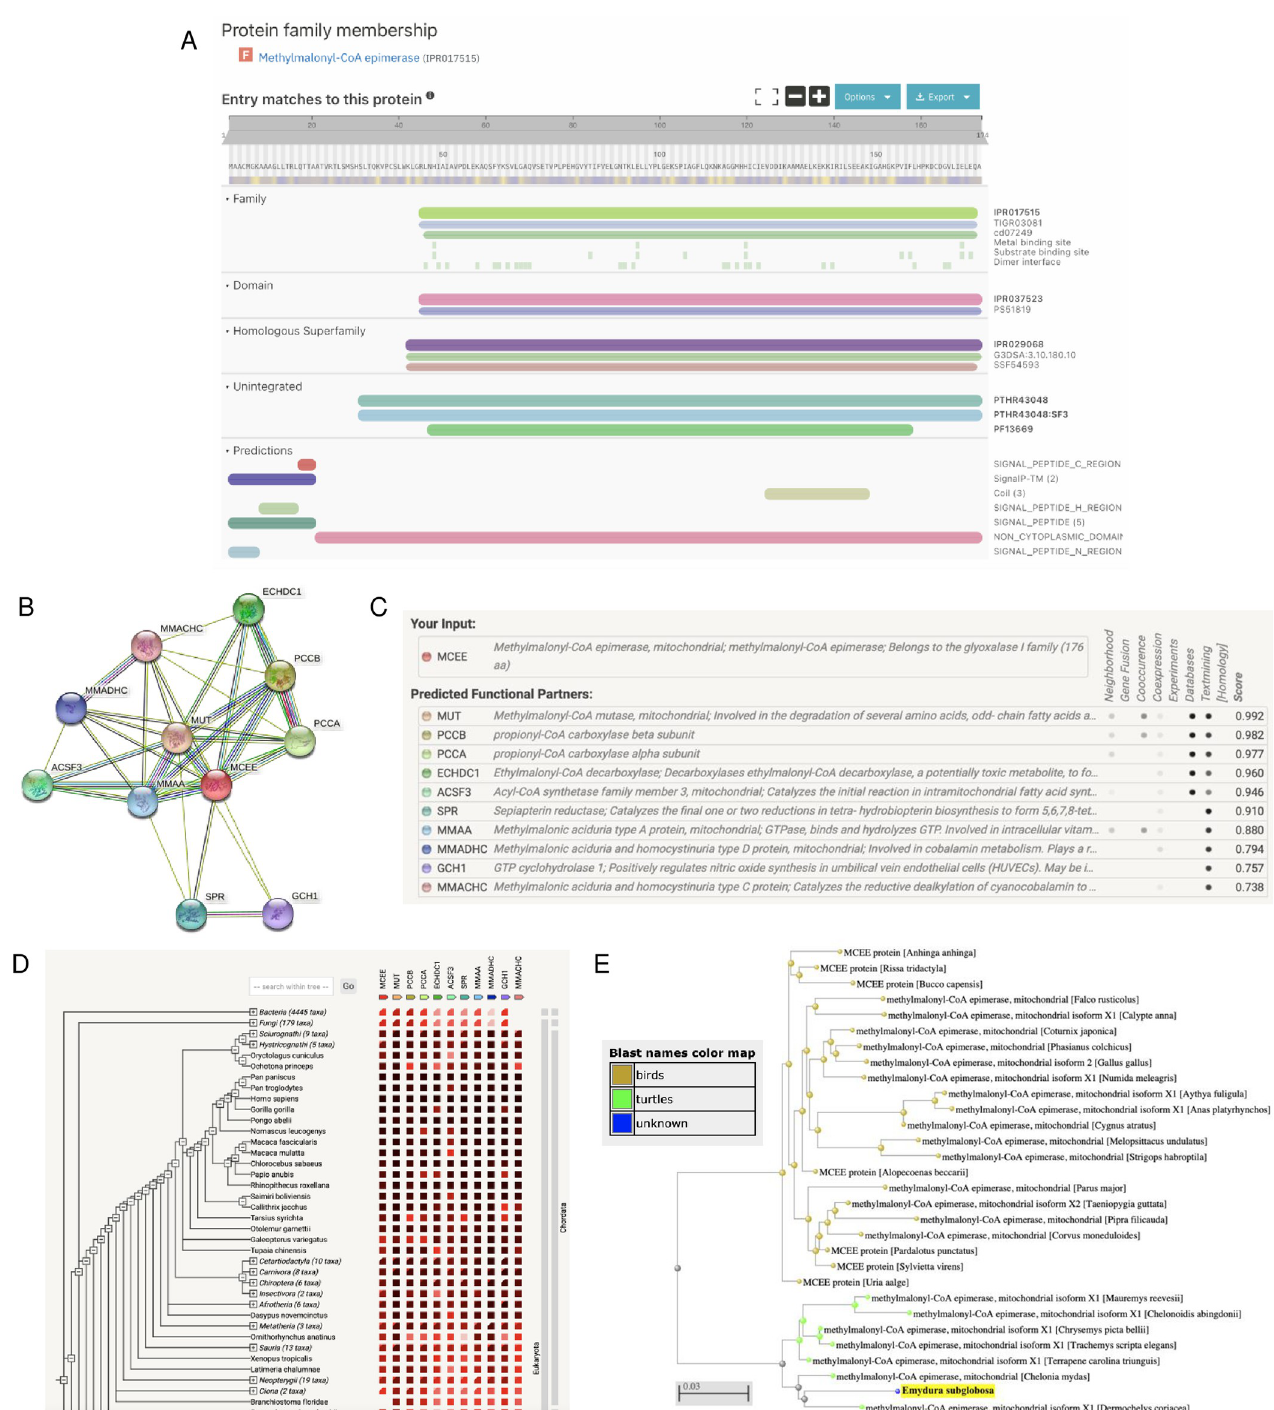
Fig 6. Functional analysis of the MCEE enzyme. (A) InterPro functional analysis of the enzyme. (B) STRING network of predicted protein-protein interactions in H . sapiens . (C) List of functional partners predicted by STRING corresponding to B. (D) Gene co-occurrence of the enzyme. (E) BLAST phylogenetic tree built based on pairwise